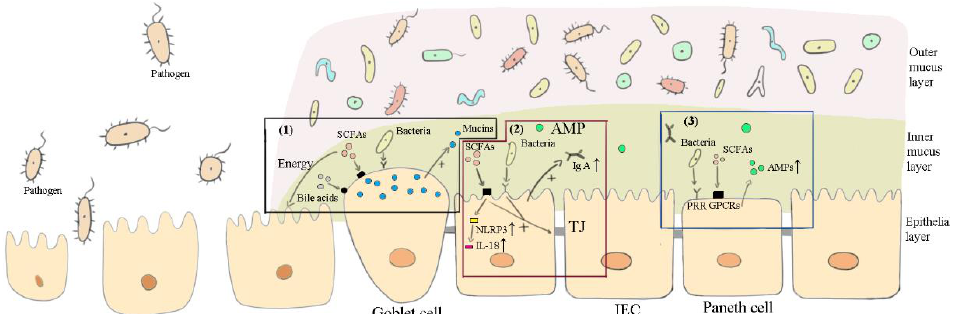
Figure 2. How the important components in FMT maintain the intestinal barrier. “+” represents promotional effects, while “-” represents suppressive effects. (1) Commensal bacteria, short-chain fatty acids (SFAs), and bile acids bind to their corresponding receptors in goblet cells, mediating mucin secretion. SCFAs provide the main energy for epithelial cells (IECs). (2) Commensal bacteria and SFAs upregulate tight junction (TJ) expressions in intestinal IECs and promote the secretion of IgA. SCFAs increase NLRP3 inflammasomes through G protein-coupled receptors (GPCRs) and further convert pro-interleukin-18 (pro-IL-18) into IL-18, which is beneficial for the intestinal barrier. (3) Commensal bacteria and SFAs promote Paneth cells to secrete antimicrobial peptides (AMPs).